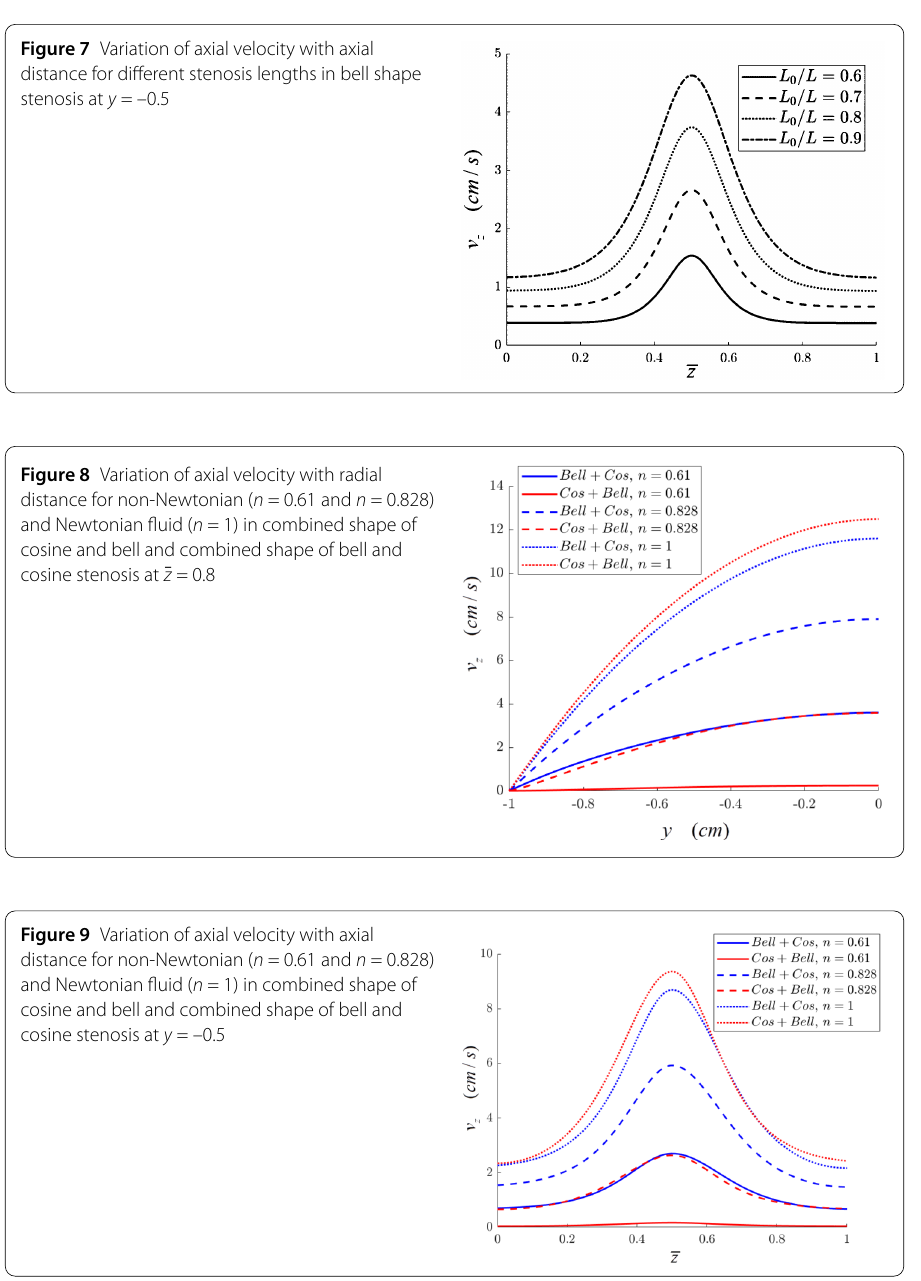
Figure 7 Variation of axial velocity with axial distance for different stenosis lengths in bell shape stenosis at y = –0.5